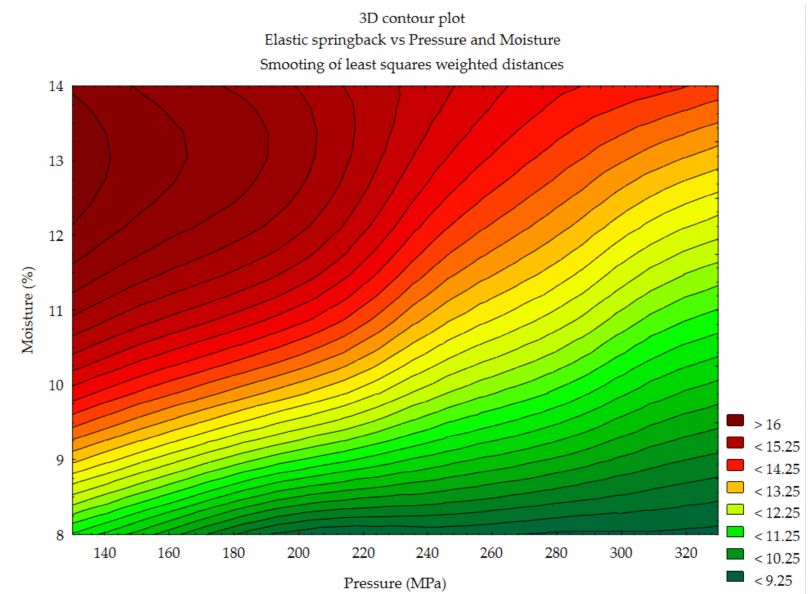
Figure 5. Elastic springback vs. pressure and